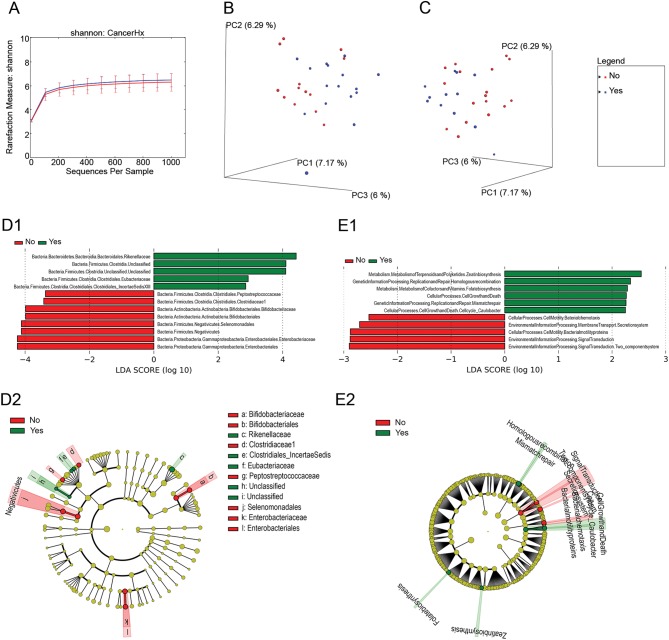
The microbiome of fecal samples is distinct between PHTS patients with and without a history of cancer. (A) Rarefaction curves comparing alpha diversity by Shannon index of fecal microbiome from patients with and without a history of cancer. (B and C) Ordination plots showing the clustering pattern of samples from patients with and without a history of cancer (B) and with and without a history of breast cancer (C) based on unweighted UniFrac distance. (D1 and D2) LEfSe differential abundance analyses of the microbiome between fecal samples from patients with (green) and without (red) cancer (D1). A cladogram demonstrates the phylogenetic relationships between differentially abundant taxa (D2). (E1 and E2) The differential KEGG pathways as revealed by PiCRUSt analysis. Clades and KEGG pathways in these graphs were considered differentially abundant if alpha > 0.05 and if the LDA log-score exceeded ±2.